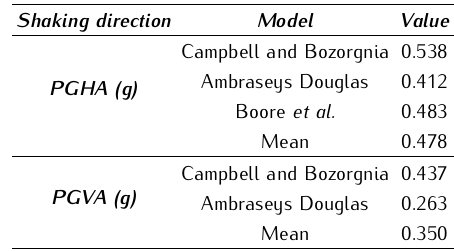
Table 3. PGHA and PGVA for MCL based on deterministic analysis of seismic